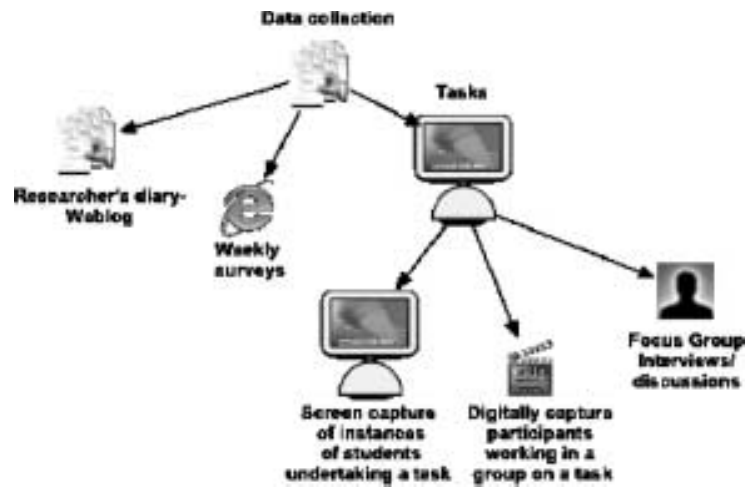
Figure 1. Flowchart for data